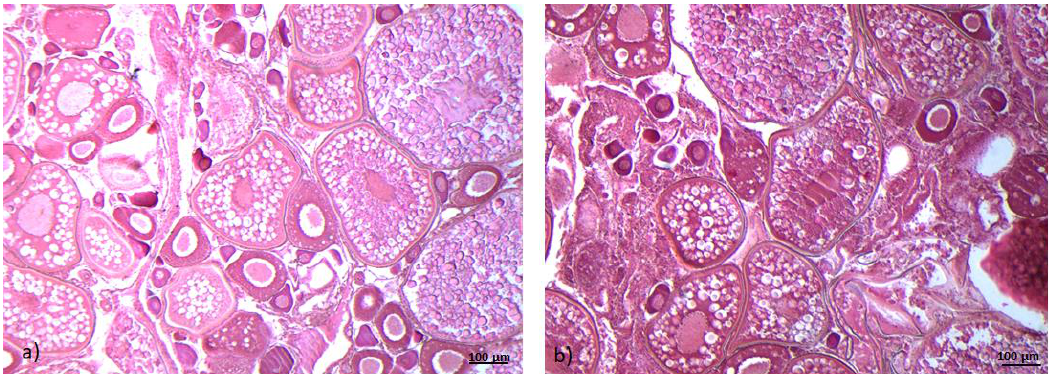
Figure 1. Histological sections of zebrafish ovaries, wild-type (wt) ( a ), zebrafish glucocorticoid (gr − / − ) mutant line, nr3c1 ia30 / ia30 (gr − / − ) ( b ). Eosin-Gill’s haematoxylin staining (10 × ). Scale bar 100 receptor (gr −/− ) mutant line, nr3c1 ia30 / ia30 (gr −/− ) ( b ). Eosin-Gill’s haematoxylin staining (10×). Scale bar 100 um.